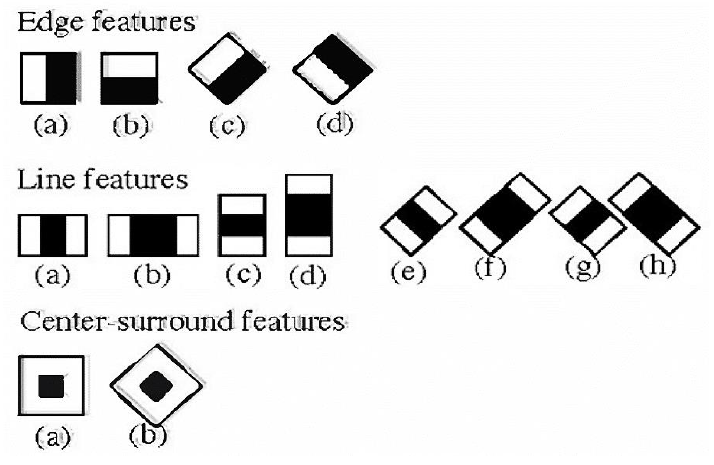
Figure 6. Haar-like features for face detection [56].